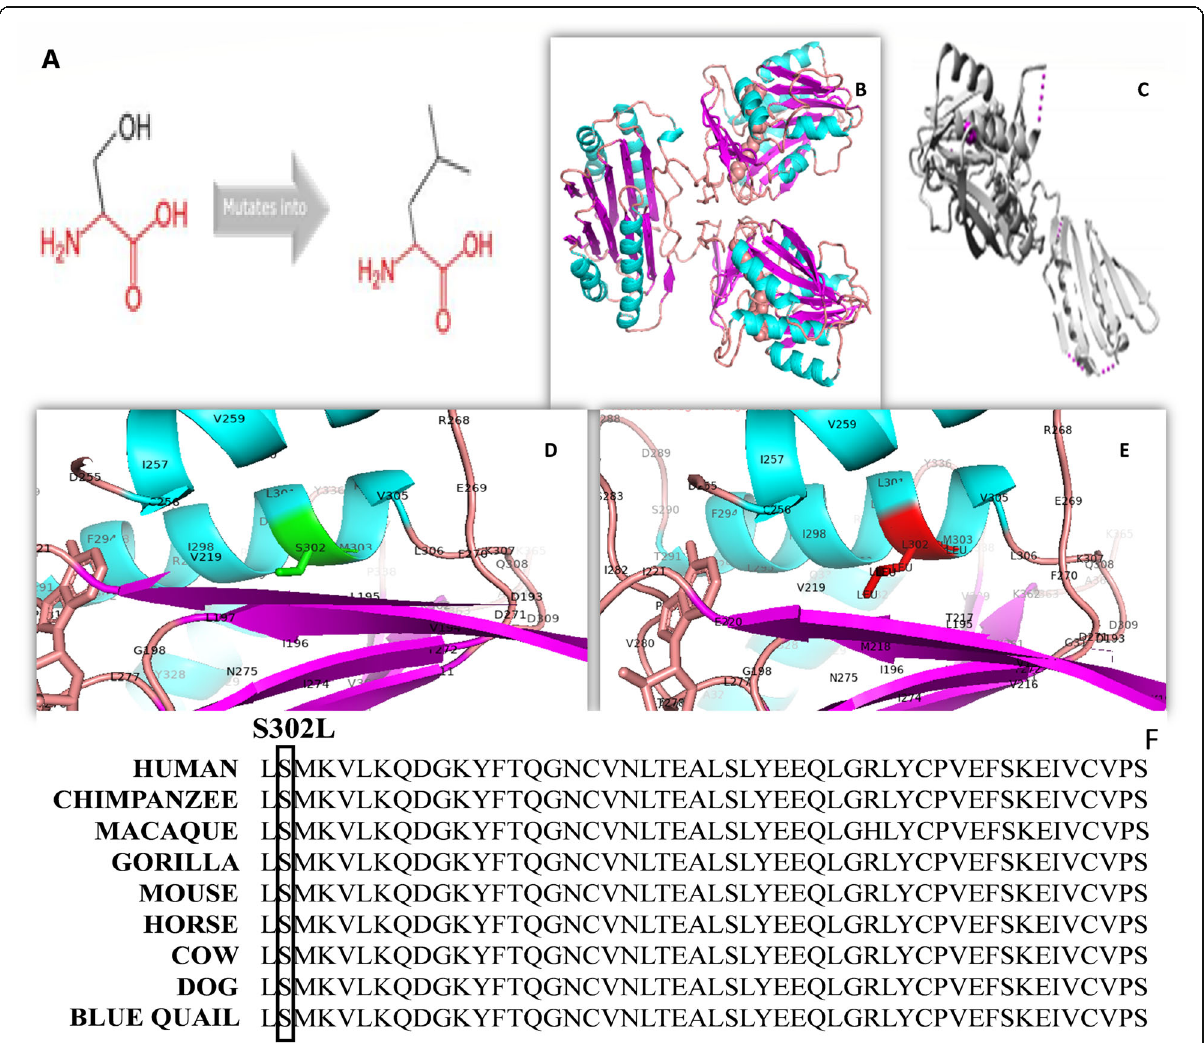
(shown in magenta color) and loops (shown in orange color). Serine is present at position 302 shown in green color. e Zoomed 3D structure of mutant SMS of human in ribbon presentation Helices (shown in cyan color), Sheets (shown in magenta color) and loops (shown in orange color). Serine is replaced by Leucine at position 302 shown in red color ( f ) Sequence alignment of SMS gene among different species. In the human sequence, amino acids from 301 to 360 are shown. The mutation site considered in this study was showing complete conservation among different species. Multiple sequence alignment is performed with Clustal Omega protein alignment